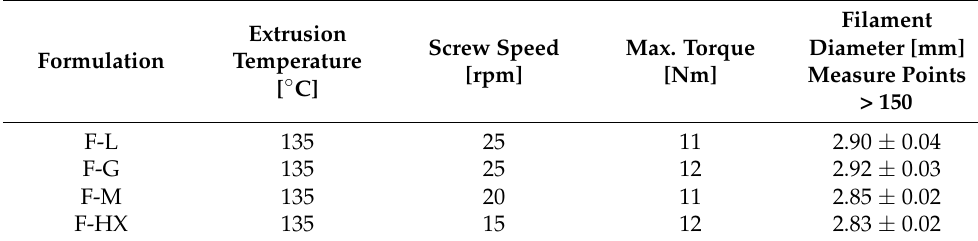
Table 3. Hot-melt extrusion parameters of extruded HEC-HPC-Diclofenac formulations and diameter results of produced filaments.